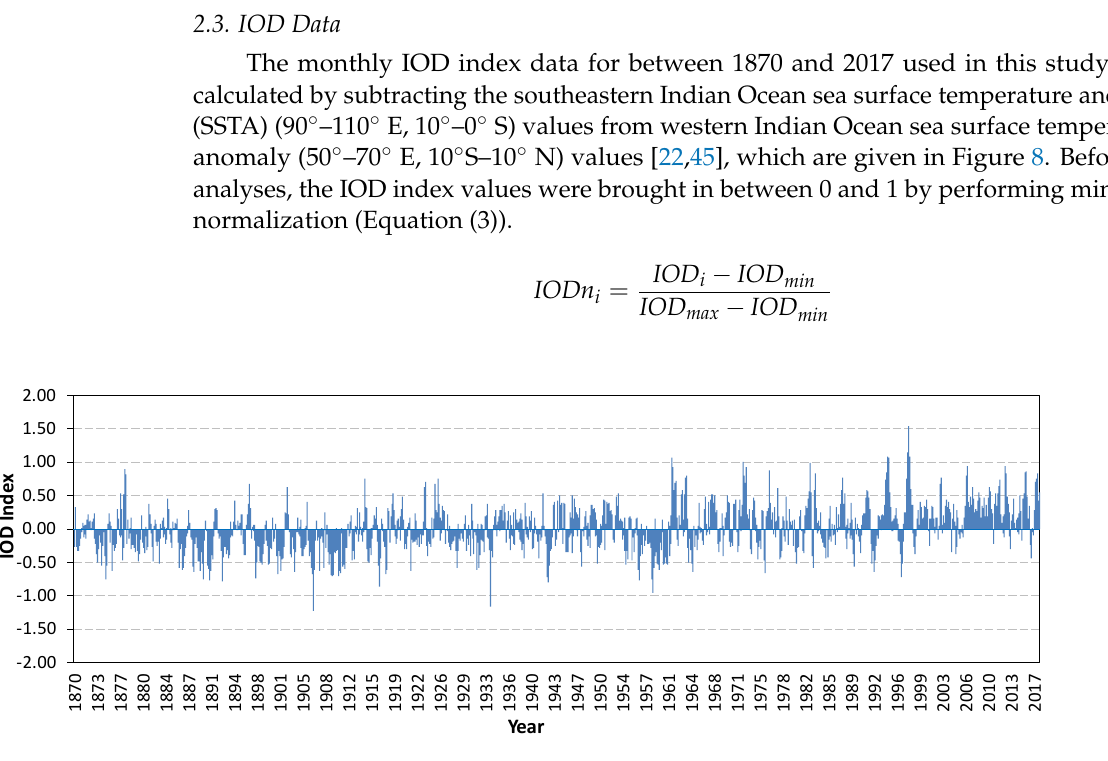
Figure 7. The monthly NAO index values for the period 1865 − 2017.